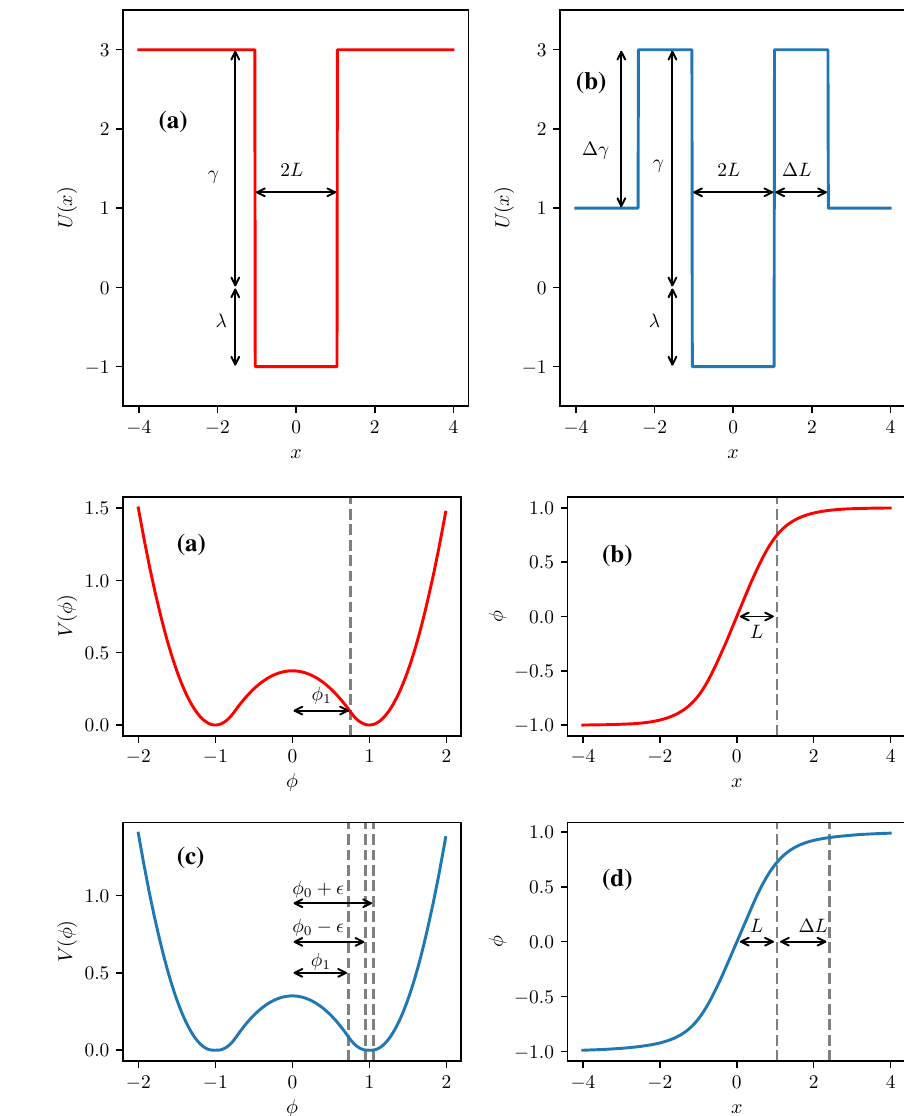
Fig. 1 Linearized potentials U ( x ) and ˜ U ( x ) . Parameters are: a γ = 3 . 0, λ = 1 . 0 and L = 1 . 047. b γ = 3 . 0, (cid:8)γ = 2 . 0, λ = 1 . 0, L = 1 . 045,